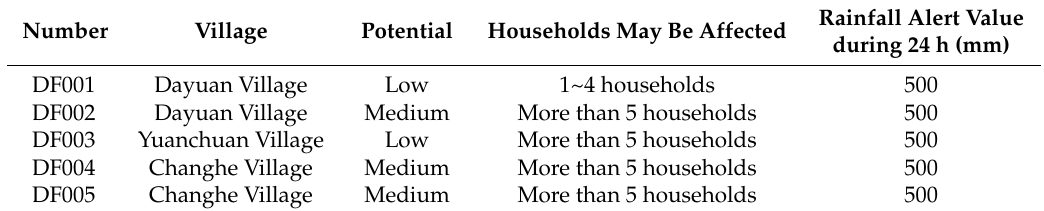
Table 7. Potential debris flow torrent in Ershui Township, Changhua